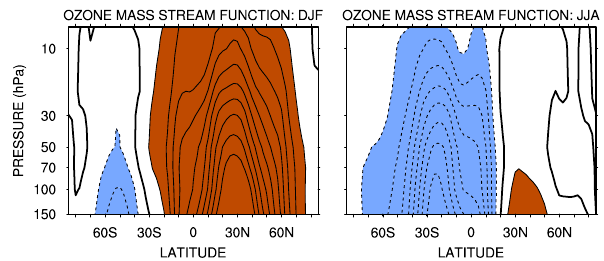
Fig. 3. Ozone density weighted Brewer-Dobson stream function av- eraged over (left) DJF and (right) JJA 1980–2001. Dashed (solid) lines and blue (brown) colors represent negative (positive) values; the bold solid line represents the zero-line. Contour spacing is 10 3 kgs − 1